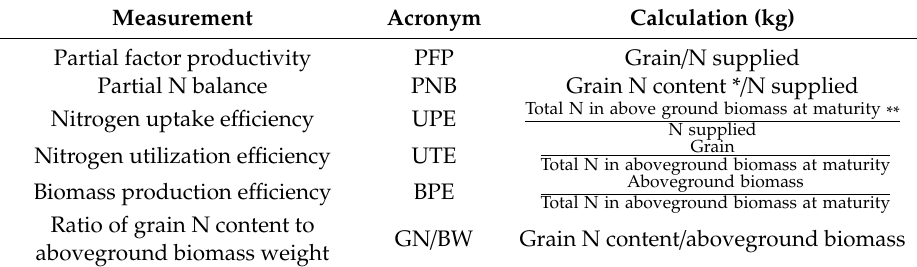
Table 2. Measurements and calculations of nitrogen use e ffi ciency and related parameters [18,20]. Measurement Acronym Calculation (kg) Partial factor productivity PFP Grain / N supplied Partial N balance PNB ∗∗ UPE Total N in above ground biomass at maturity N supplied UTE Grain Total N in aboveground biomass at maturity BPE Ratio of grain N content